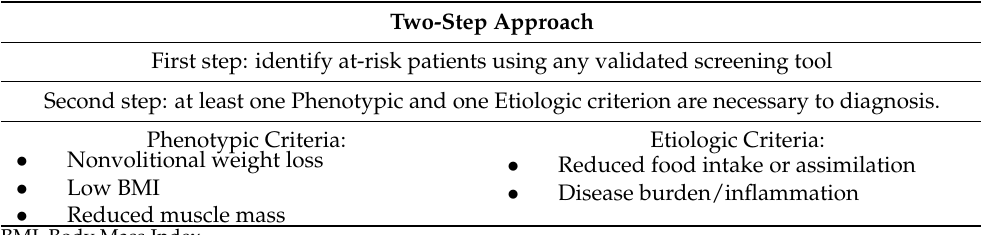
Table 3. Diagnostic criteria for malnutrition according to the Global Leader Initiative on Malnutrition [19]. Two-Step